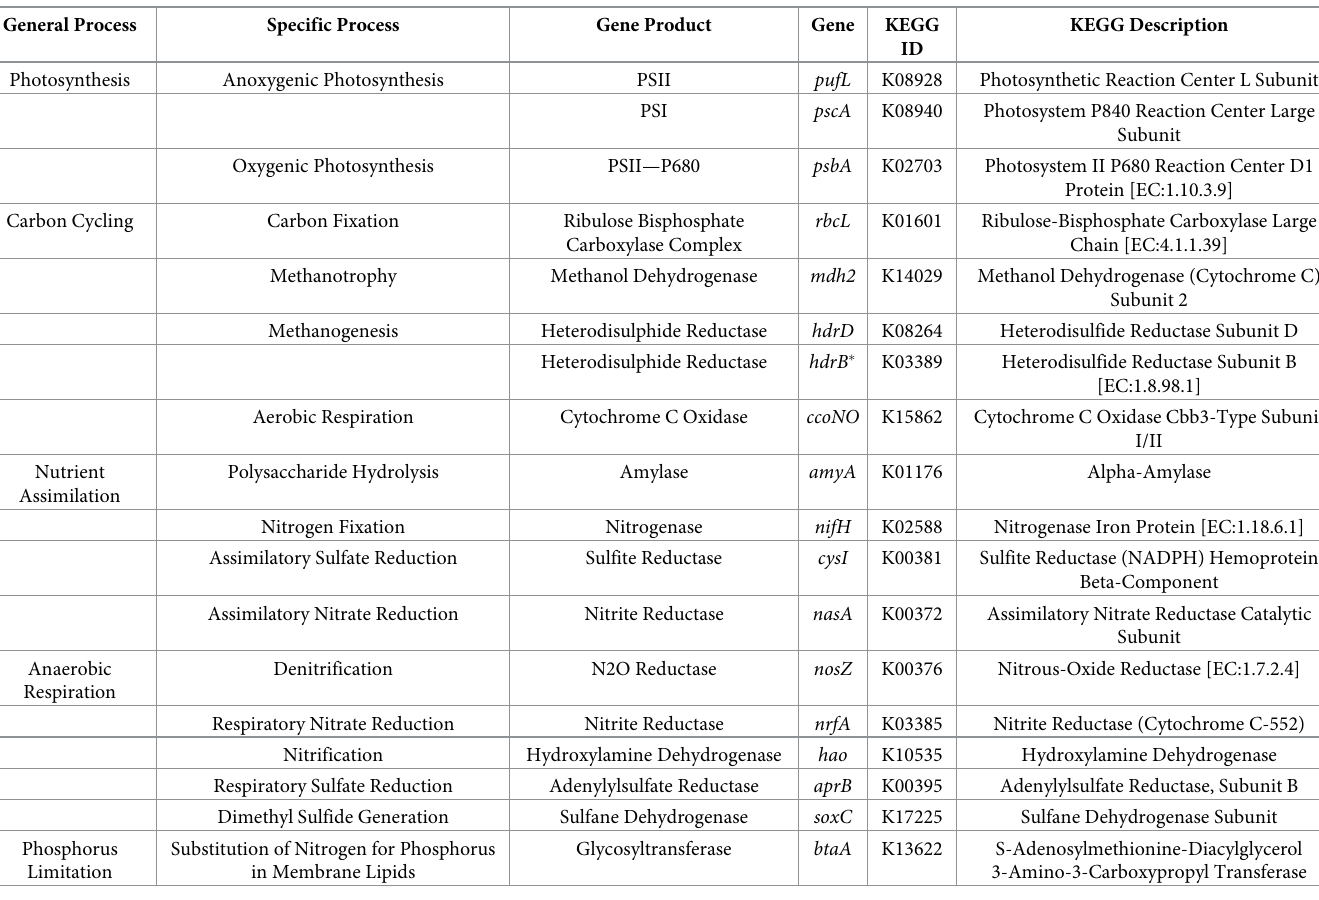
Table 1. Metabolic marker